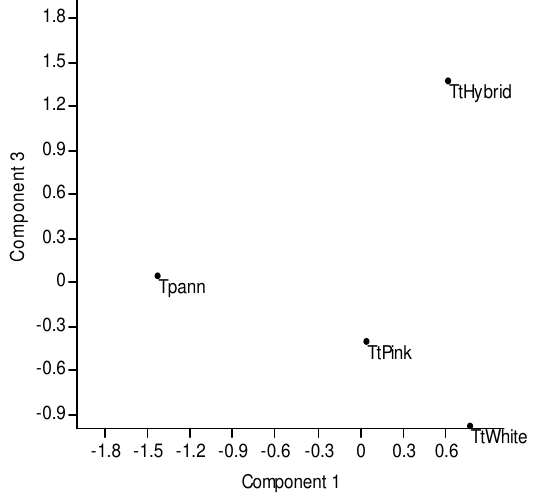
T . triangulare white petals